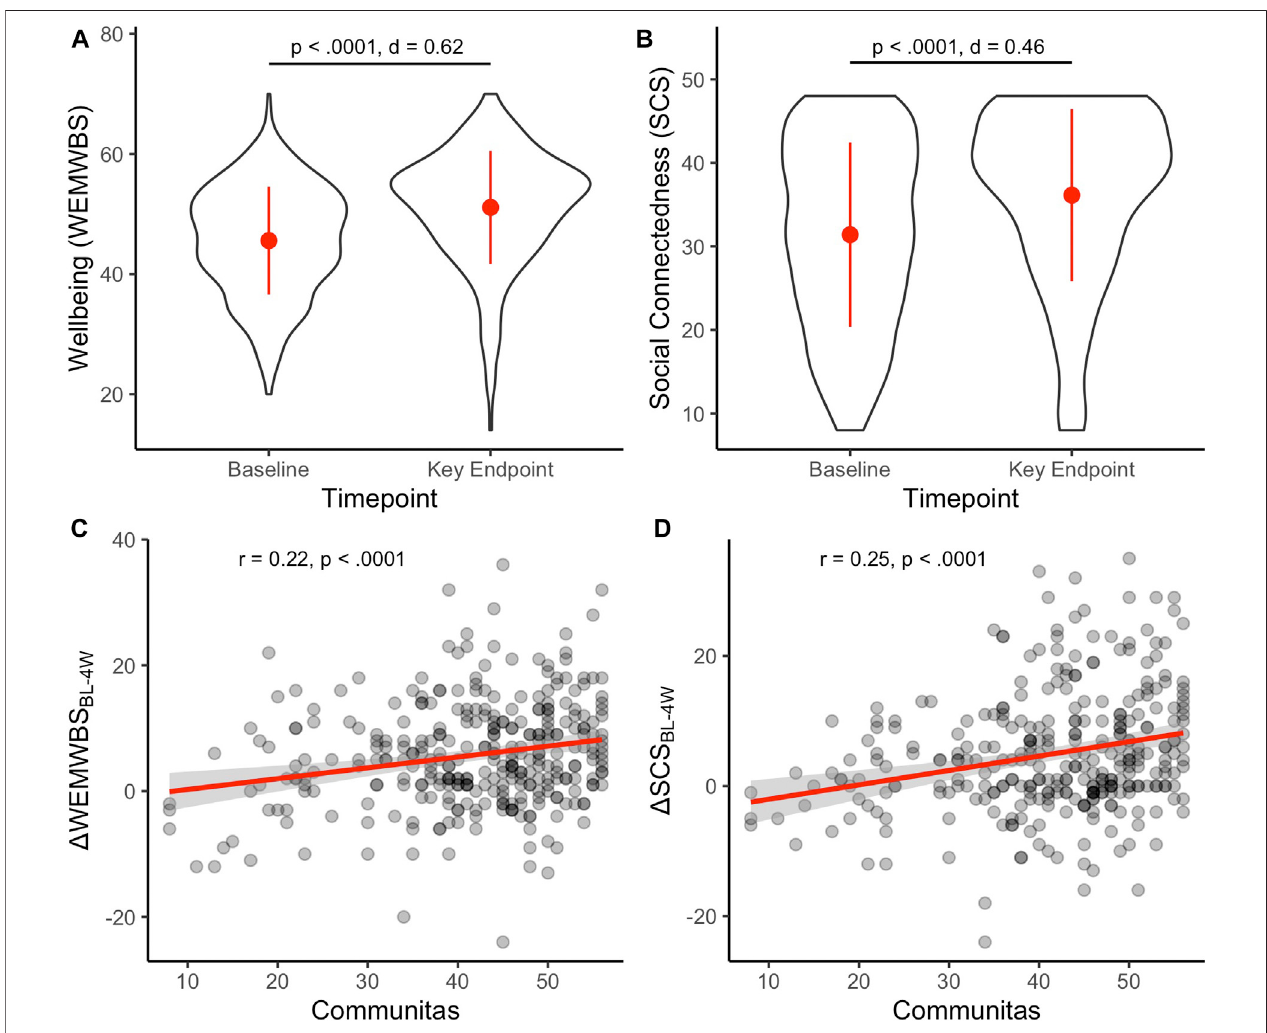
FIGURE5 | Post-psychedelic increasesin psychologicalwellbeing (WEMWBS, A) and social connectedness (SCS, B) positively correlate withcommunitas (C , D) experienced during ceremony. Red dots and lines represent mean ± SD (A, B) , or trend lines (C, D) .